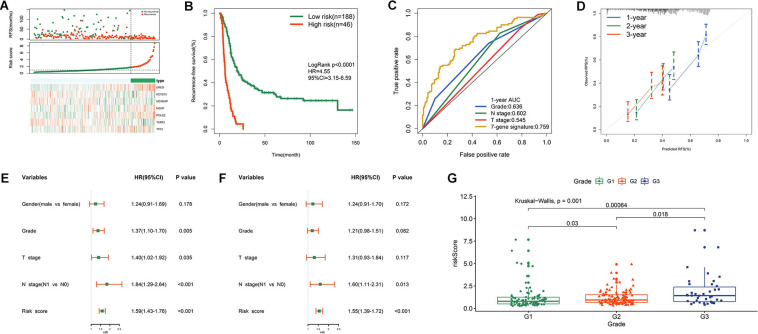
Prognostic performance of risk signature in MTAB-6134 cohort. (A) From top to bottom are the survival status distribution, risk score distribution and heat map analysis of seven genes. (B) RFS difference between low- and high-risk groups. (C) ROC analysis of the risk signature. (D) Calibration curves for risk score. (E) Univariate and (F) multivariate Cox regression analyses of clinical pathologic features and gene signature for RFS. (G) Distribution of risk scores in different histological grade.